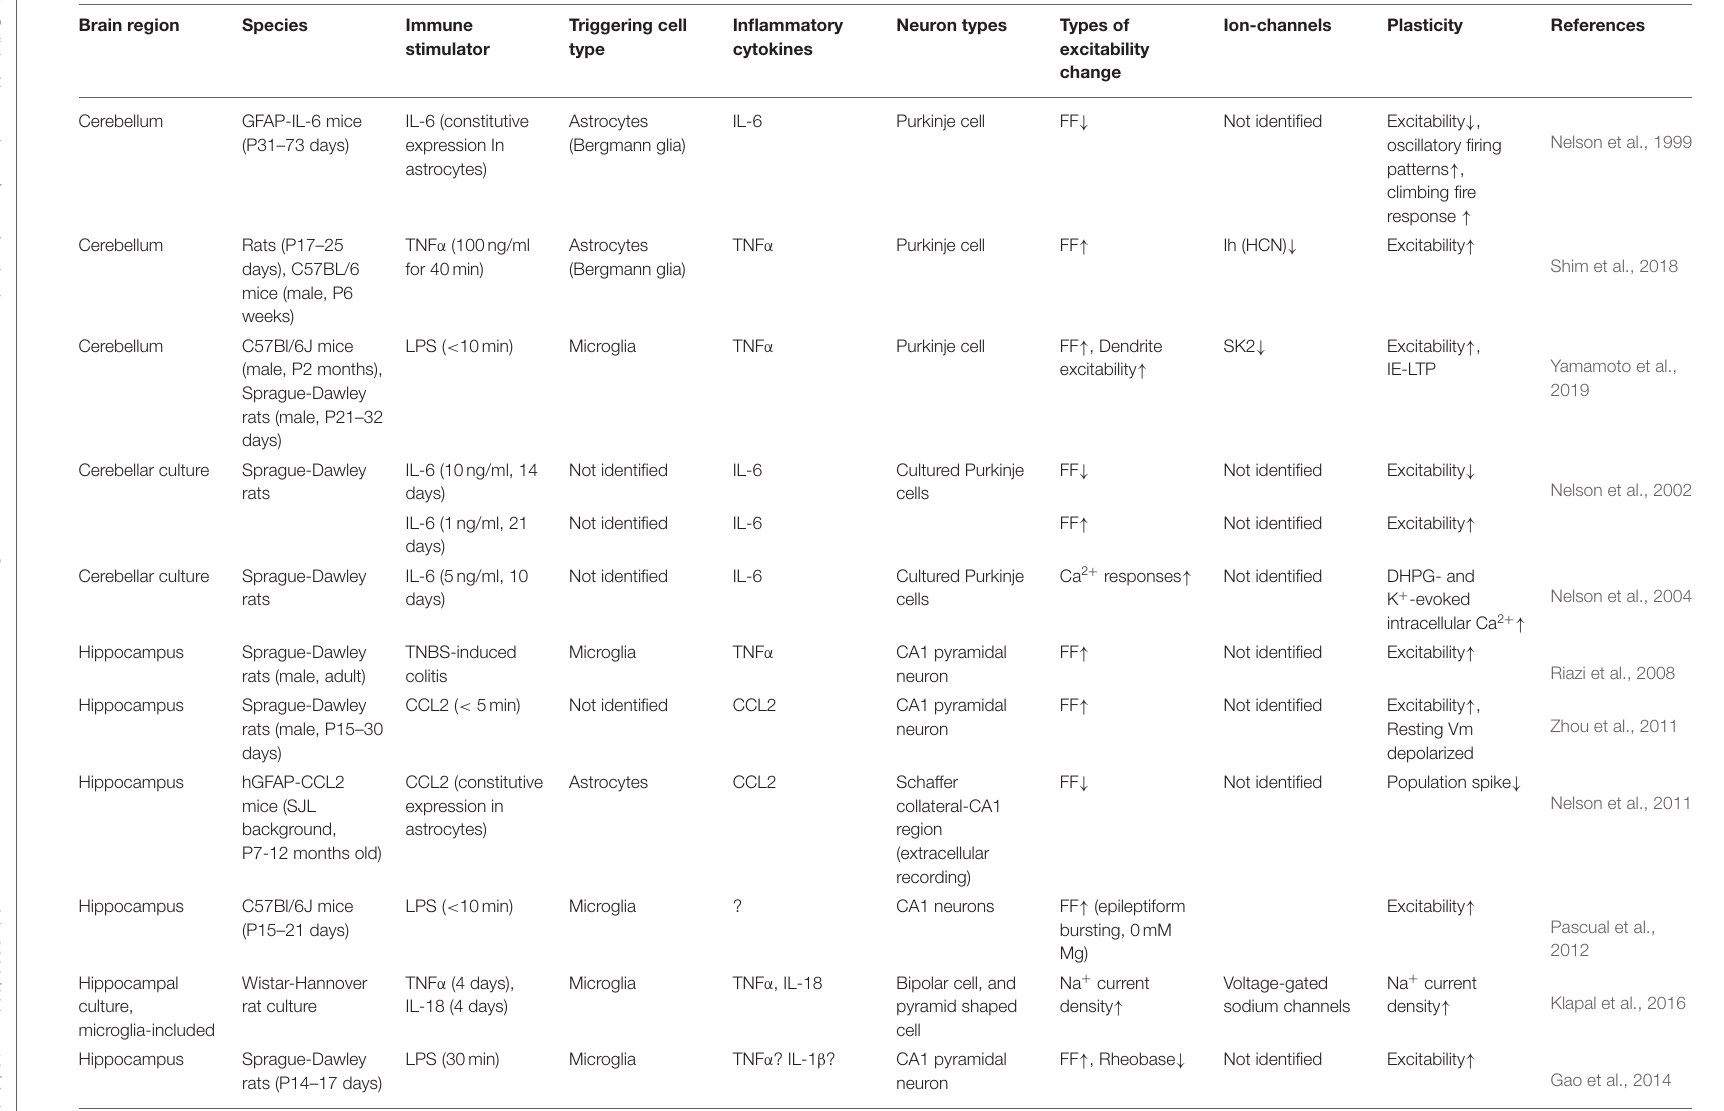
TABLE 2 | Immune-triggered modulation of the intrinsic excitability of